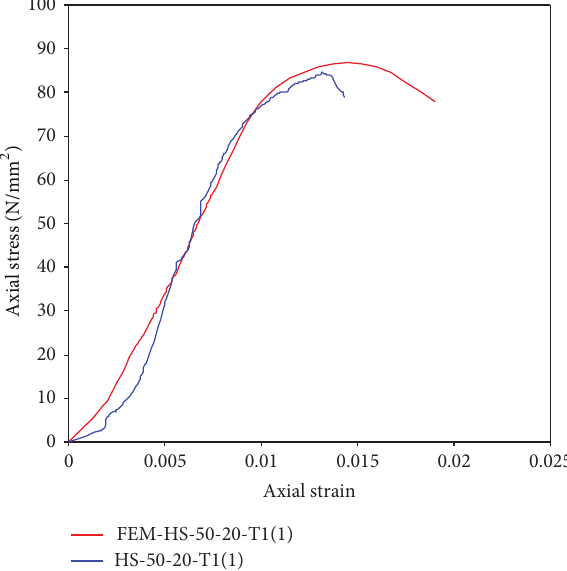
Figure 30: Comparison of experimental and computed axial stress-strain behaviours of HS-50-20-T1 (1) columns.